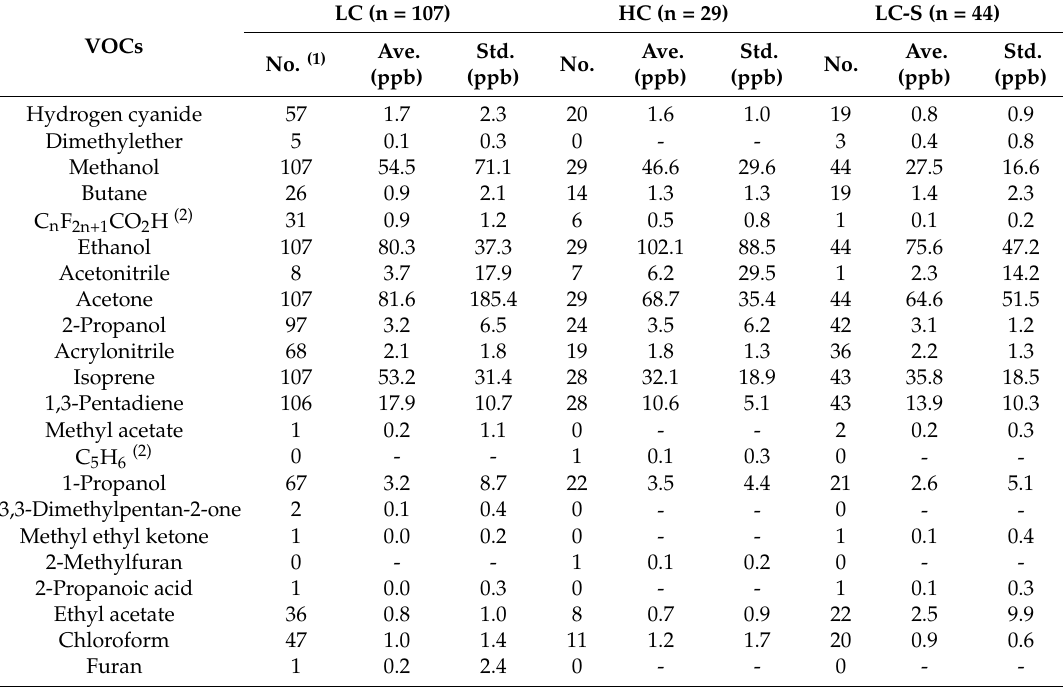
Figure 5. GC/MS spectra of exhaled breaths from: ( a ) a patient with lung cancer (IA, Ad); ( b ) another patient with lung cancer (IIIA, Ad); ( c ) a healthy control; and ( d ) the patient from ( b ) after undergoing surgery. Table 2. VOCs identified in exhaled breaths and their average concentrations and standard deviations.